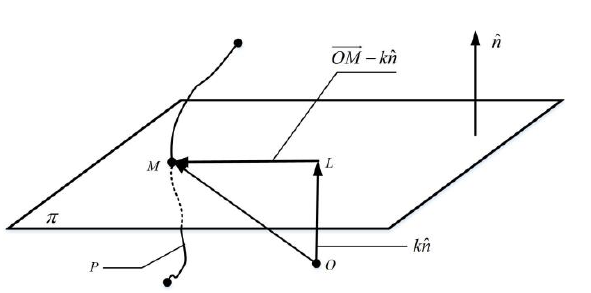
Figure 4. Intersection schematic diagram of the tangent plane and boundary line based on the vector method.